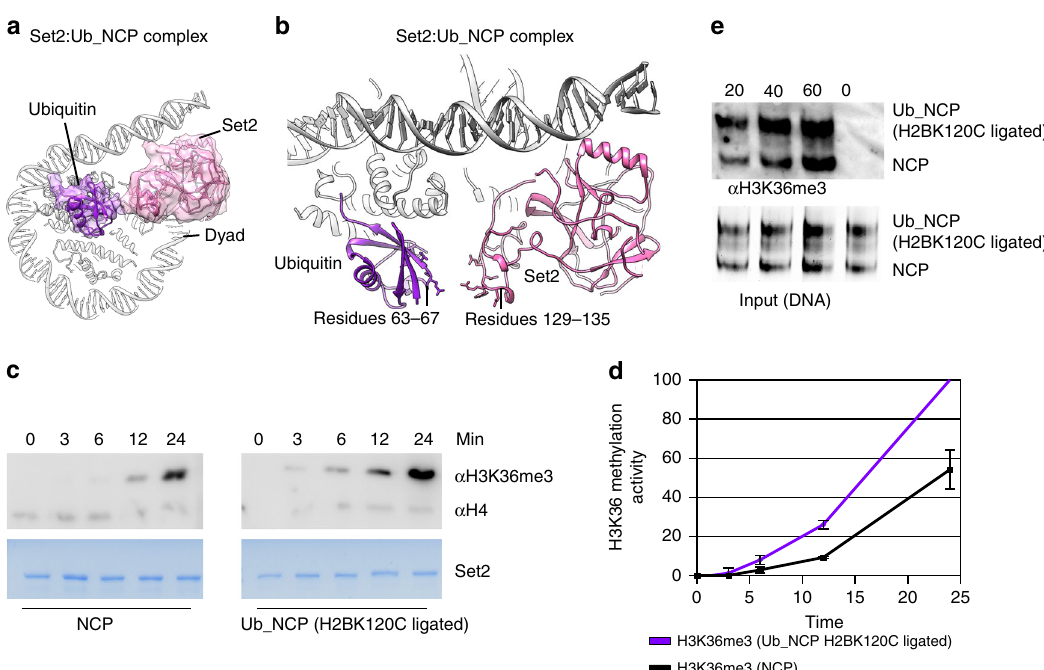
Fig. 4 Ubiquitin binds Set2 and stimulates Set2 H3K36me3 activity. a Cryo-EM map resolved to 4.1 Å showing a subset of particles with de fi ned density for ubiquitin, which interacts with Set2. Ubiquitin density and model are shown in violet. Set2 density and model are shown in pink. NCP is shown as model in gray. b The model showing overall interaction between Set2 and ubiquitin. Ubiquitin residues 63 – 67 come to close proximity to Set2 AWS domain (residues 129 – 135). c Set2 methyltransferase assay with the unmodi fi ed and the H2BK120C ubiquitinated nucleosomes. In presence of H2BK120C ubiquitin, Set2 shows increased H3K36me3 when compared with unmodi fi ed nucleosome. d Quanti fi cation of Set2 methyltransferase activity assay from ( c ) . Error bars show standard error of three independent replicates. e Set2 methyltransferase competition assay with equimolar amounts of both the unmodi fi ed and the H2BK120C ubiquitinated nucleosomes. The nucleosomes were separated on the native gel: sample stained with SybrGold is shown in the lower panel and tri-methylation activity detected with H3K36me3 antibody in the upper panel. Upper band is the H2BK120C ubiquitinated nucleosomes and the lower band are the unmodi fi ed nucleosomes. Source data are provided as a Source Data fi le